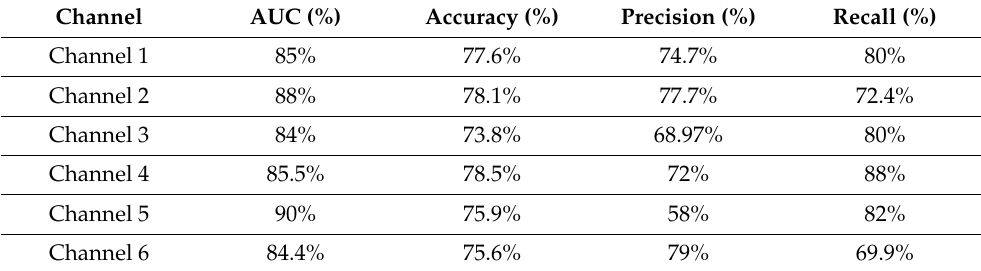
Table 2. Accuracy, area under curve (AUC), precision and recall results for model 1, 8 min window.